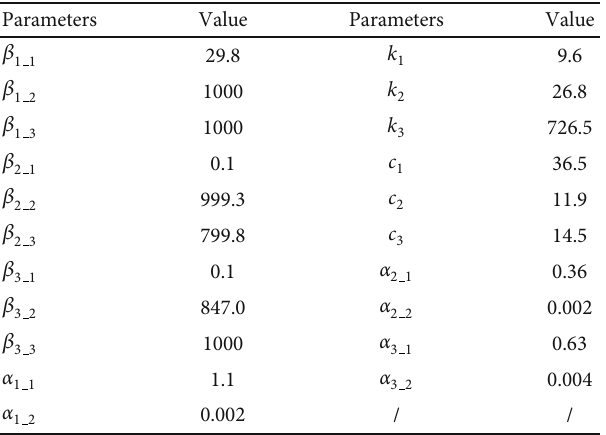
Table 4: Optimal parameters of SMC-NESO. Parameters